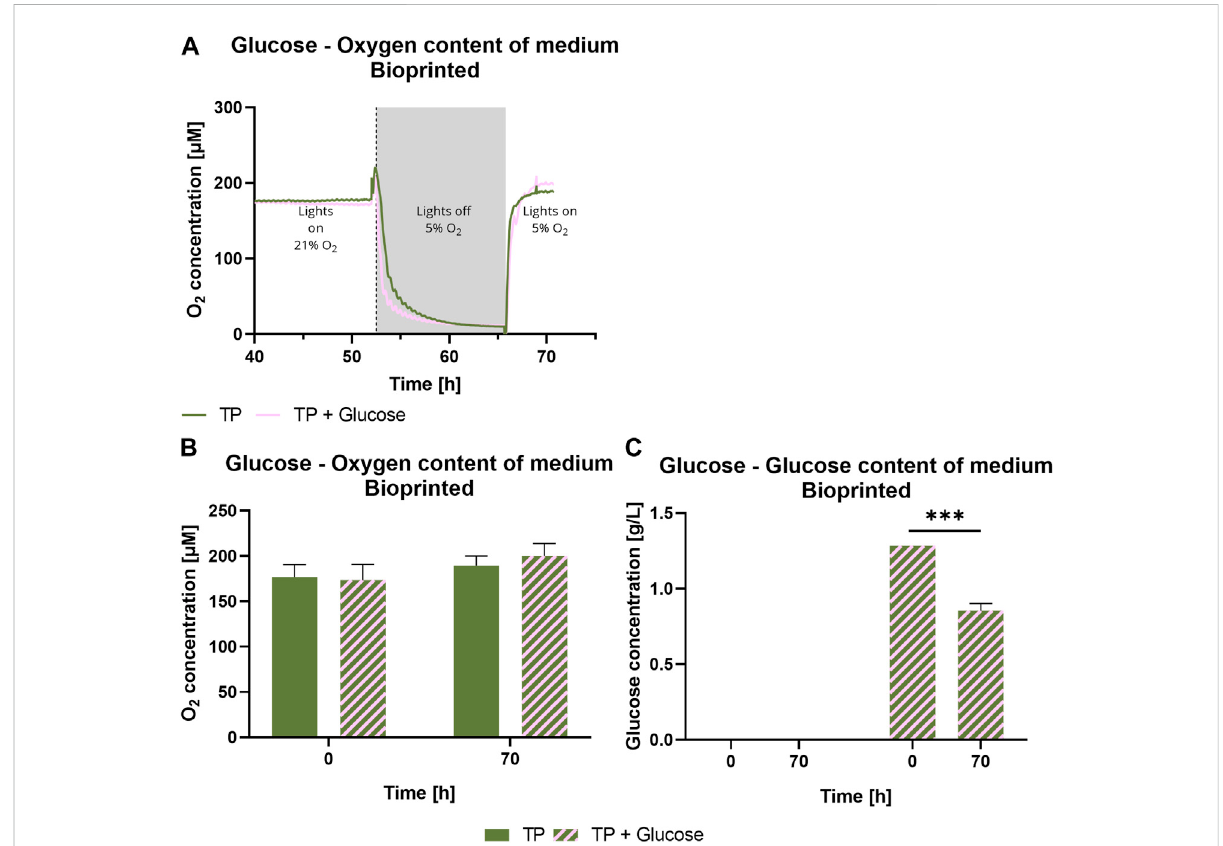
FIGURE 7 Oxygen content over time (A) , at 0 and 70 h (B) and glucose concentration (C) of medium of 3D bioprinted Scenedesmus sp.; cultivated for 3 days under red illumination (150 µmol/m 2 s) at 37 ° C and normoxia in TP medium without and with 7.1 mM glucose before the oxygen content was decreased to 5% after approximately 52 h. Simultaneously, the light was turned off until the samples reached a hypoxic state. Depicted are mean values, n = 4 (A) , mean ± standard deviation, n = 4 (B,C) ; *** p <